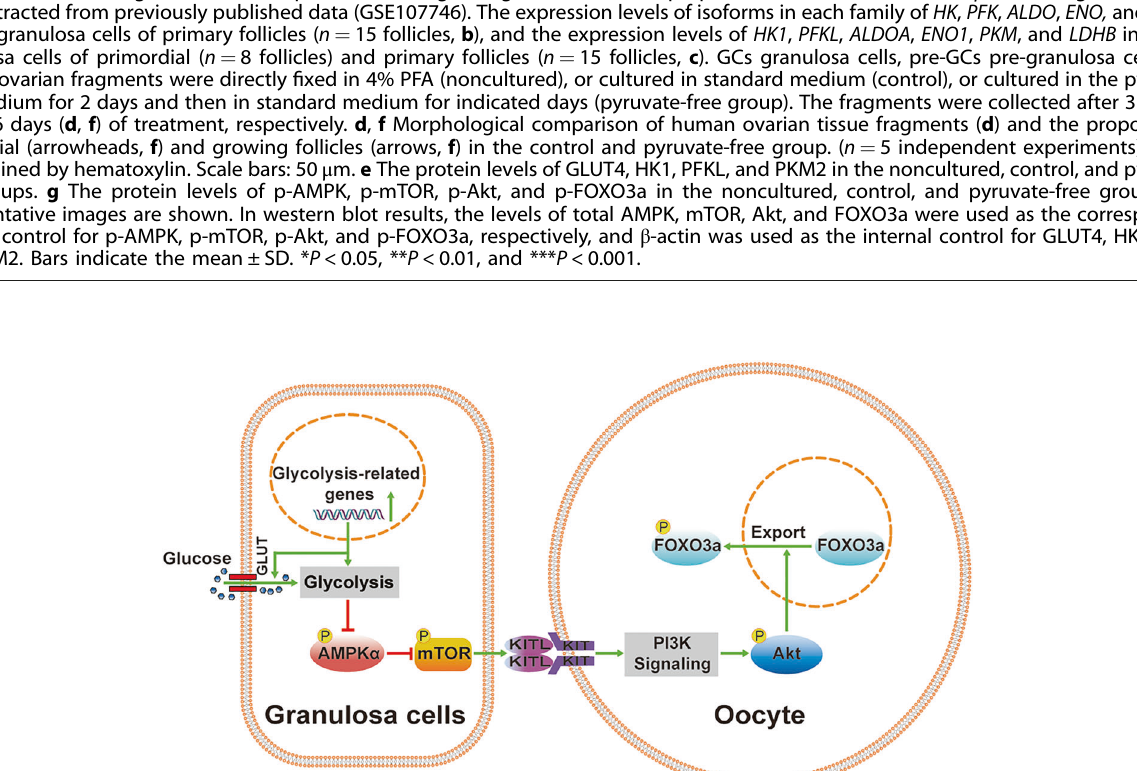
Fig. 7 The proposed model of glycolysis in primordial follicle activation. Enhanced glycolysis in granulosa cells activates mTOR signaling by decreasing AMPK activity. This process triggers the transduction of KITL signaling in pre-granulosa cells to PI3K-Akt-FOXO3a signaling in oocytes, resulting in the activation of dormant primordial